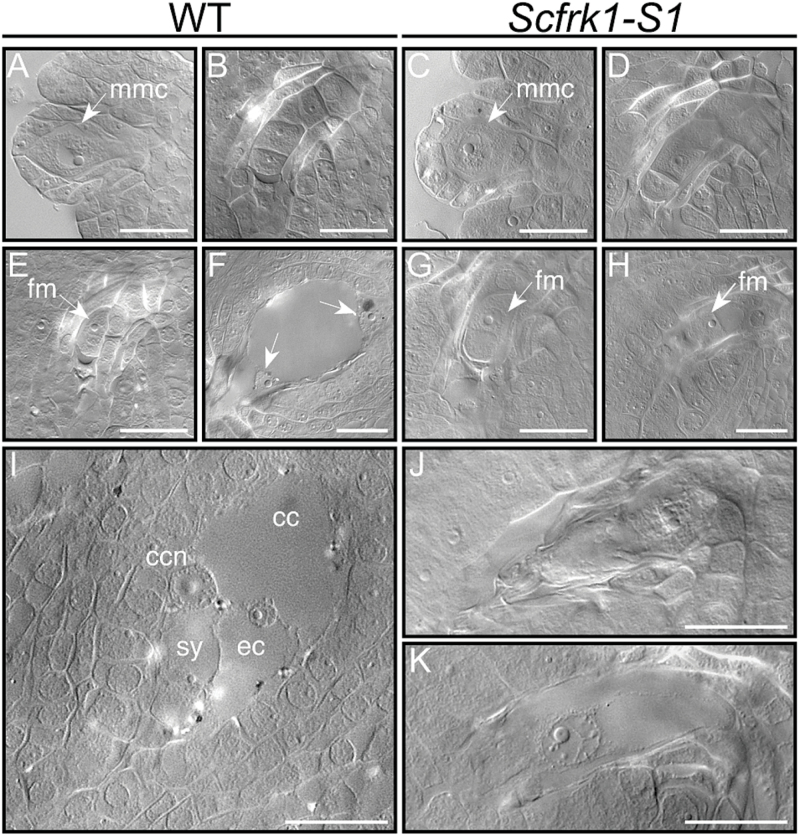
Megasporogenesis and megagametogenesis in WT S. chacoense and in the Scfrk1-S1 transgenic plant line. Cleared ovules were observed by DIC microscopy. Stages determined following Table 2. (A, C) Megaspore mother cell stage. (B, D) Tetrad stage. (E, G) Functional megaspore stage (FG1). (F, H) Binucleated megagametophyte stage. In F, the arrows point to the two nuclei in the late two-nucleate stage (FG3). In H, embryo sac development is halted at the FG1 stage in the Scfrk1-S1 transgenic line. (I, J, K) Mature embryo sac stage at anthesis (FG8). mmc, megaspore mother cell; fm, functional megaspore; cc, central cell; ccn, central cell nucleus; sy, synergid cell; ec, egg cell. Scale bar=20 μm.